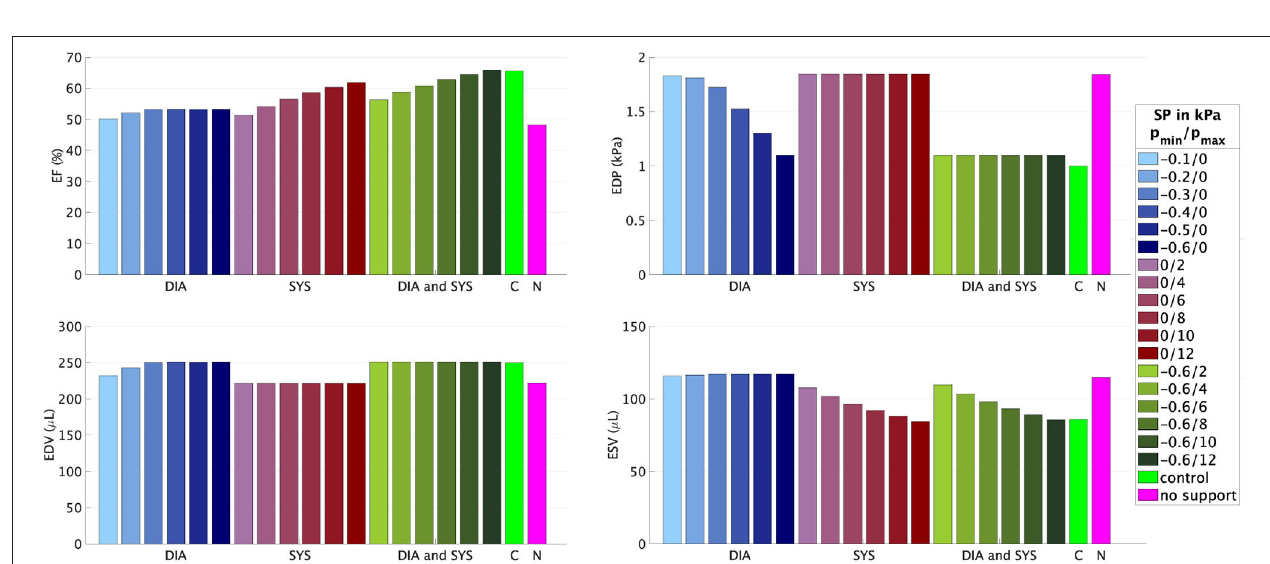
FIGURE 5 | Ejection fraction, EDP, EDV, and ESV for different combinations of the minimal p min and maximal p max values of the support pressure (SP) applied to the epicardial surface of the model with fib = 0.3. DIA, diastolic support (blue); SYS, systolic support (red); DIA and SYS, combined support (green); C, control rat LV (light green); N, rat LV with fib = 0.3 without any support (blue-green).